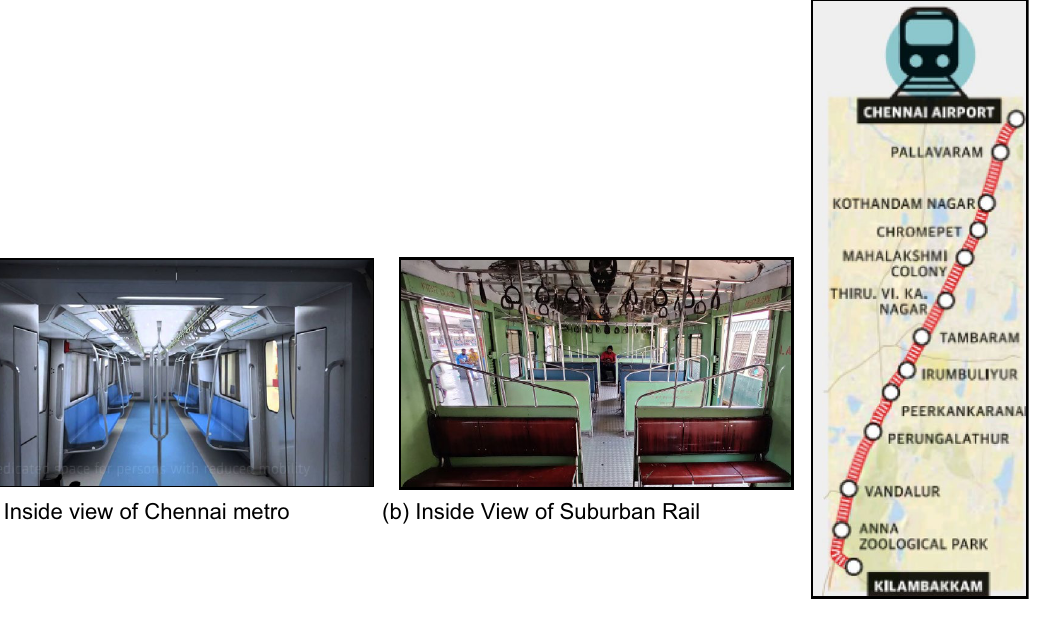
Source: Indian Railways website *Study corridor under expansion